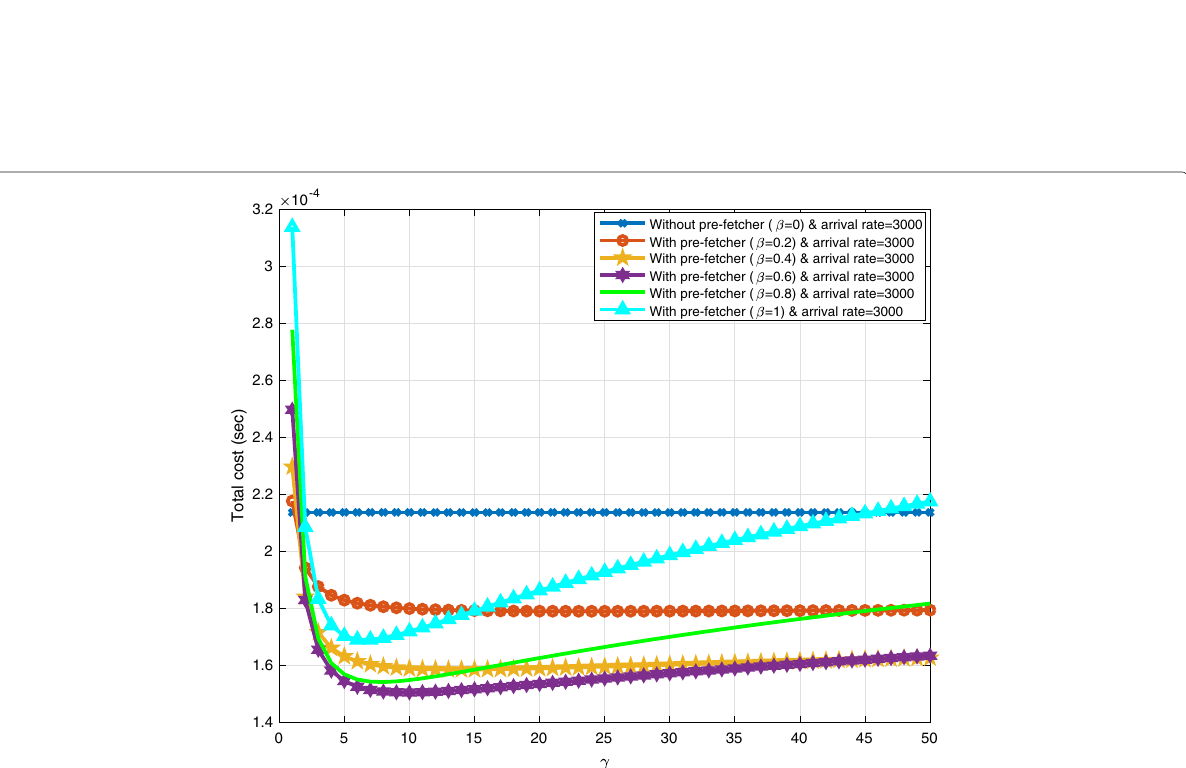
Fig. 9 Impact of increasing β and γ when λ = 3000. Without pre-fetcher ( β = 0) and arrival rate=3000, With pre-fetcher ( β = 0.2) and arrival rate=3000, With pre-fetcher ( β = 0.4) and arrival rate=3000, With pre-fetcher ( β = 0.6) and arrival rate=3000, With pre-fetcher ( β = 0.8) and arrival rate=3000, With pre-fetcher ( β = 1) and arrival